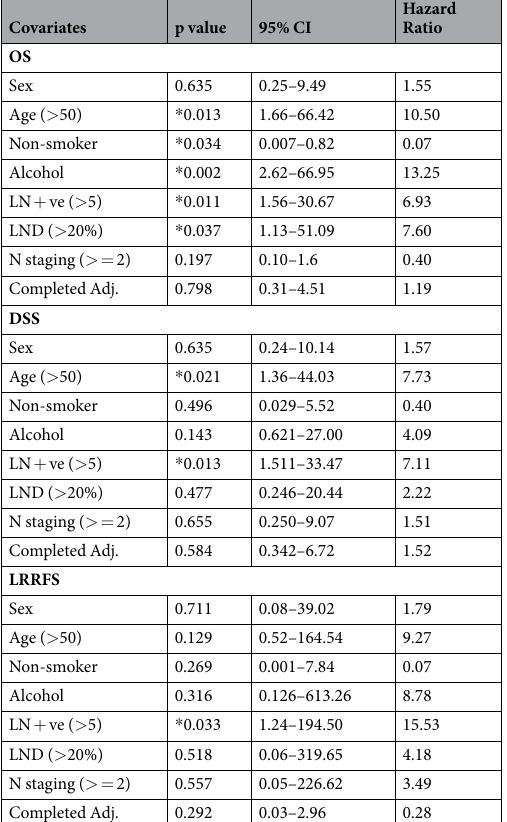
Table 4. Multivariate analysis. These are the outputs for multivariate analysis with proportional hazards regression for OS, DSS, and LRRFS. Notes: OS = overall survival; DSS = disease specific survival; LRRFS = locoregional recurrence free survival. LN + ve ( > 5): Number of positive lymph nodes more than five; LND ( > 20%): lymph node density more than twenty percent; N staging ( > = 2), Pathological N classification with N more than or equals to two; Completed Adj.: Patients who had a completed course adjuvant therapy. 95% interval and Hazard Ratio was not calculated for smokers as it was the reference category for smoking status in this regression